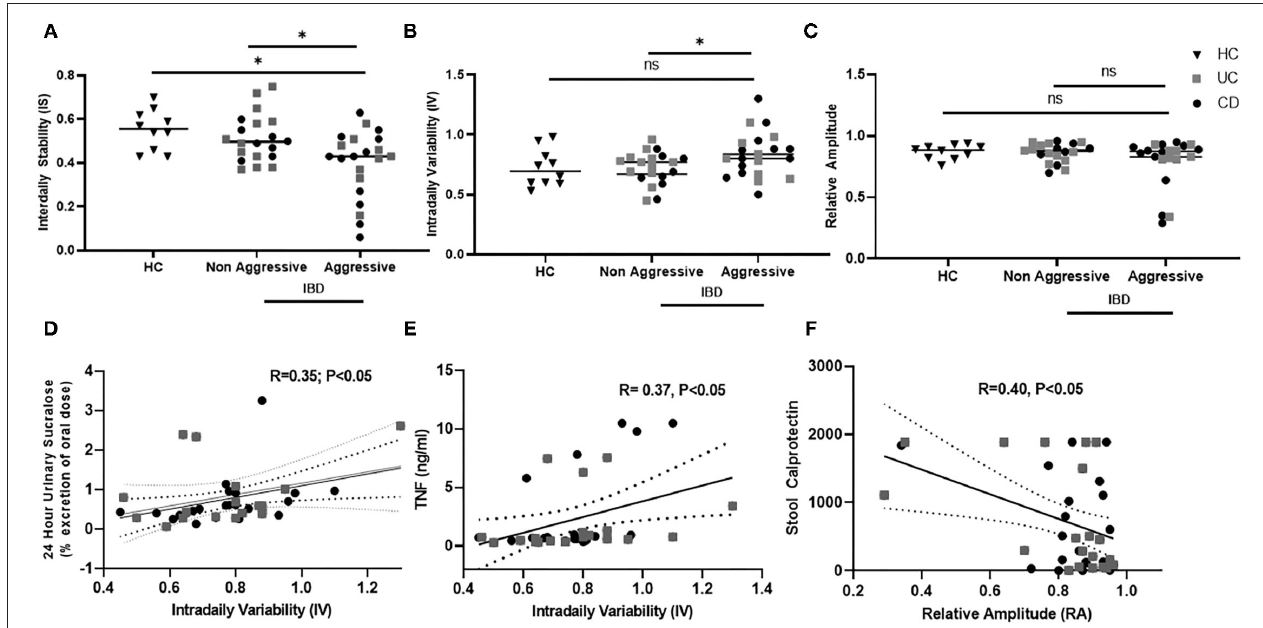
FIGURE 2 | Circadian rest-activity cycles in inactive IBD by disease history and subclinical inflammation. Wrist Actigraphy was used to determine non-parametric variables—interdaily stability (IS), intradaily variability (IV), and relative amplitude (RA). relating to rest-activity circadian cycles. Disease History was compared to (A) IS, (B) IV, and (C) RA. IS and IV were increased in Aggressive IBD. IV associated was associated with increased (D) intestinal permeability and (E) TNF- α . Decreased RA was associated with (F) increased stool